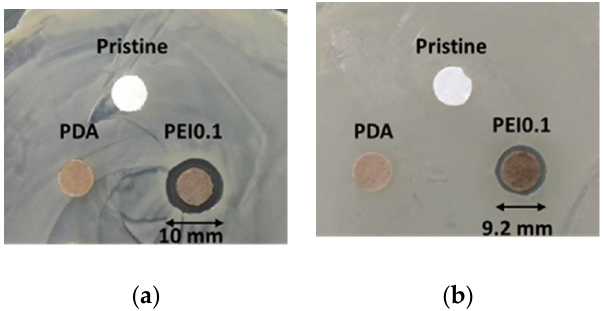
Figure 5. Antibacterial activity of diffusion inhibition zone test for different filter papers. ( a ) S. aureus ( b ) E. coli.